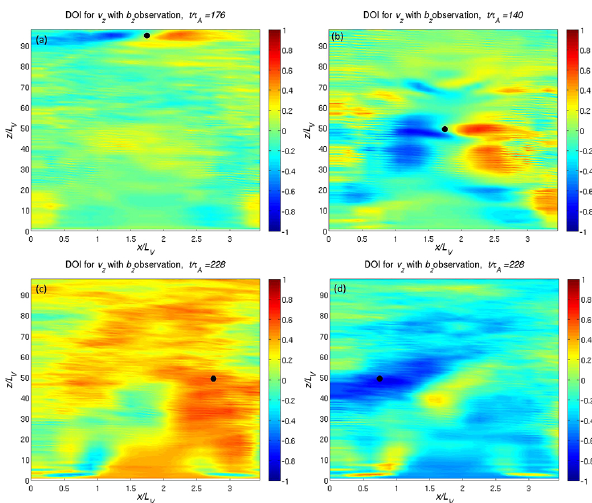
Fig. 11. Domain of influence for the z component of the solar wind velocity v z for the assimilation of a magnetic field observation taken at different locations and different times. The black circle indicates the data observation location. (a) refers to location 4 (L1) and time t/τ A = 176, (b) to location 3 and time t/τ A = 140, panel (c) to lo- cation 5 and (d) to location 6, both at time t/τ A = 228. The spatial dimensions are normalised to L v = L B , the length scale of variation of the velocity; time is normalised to the Alfvén time τ A .